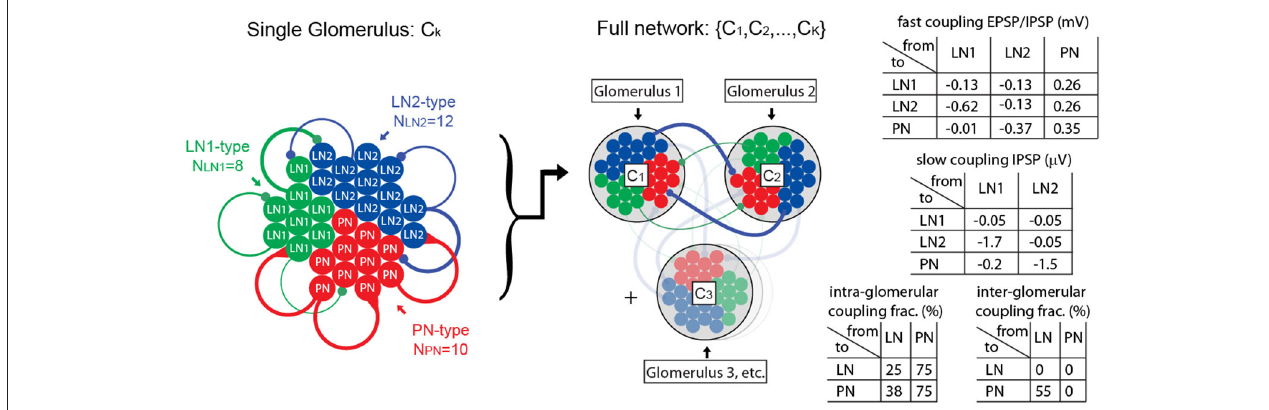
FIGURE 1 | Illustration of computational network architecture. On the left we illustrate the anatomy of a single glomerulus, comprising 10 PNs, 8 LN1s, 12 LN2s, each modeled using single-compartment integrate-and-fire equations. These neuronal populations are connected together sparsely via local intra-glomerular connections. Representative connections are illustrated in this diagram with colored lines, the thickness of which roughly corresponds to the coupling strength. In the middle we illustrate our full network, comprising K glomeruli (e.g., K = 2 –6). The neuronal populations within each of these glomeruli are connected together sparsely via long-range inter-glomerular connections; these long-range connections have the same synaptic strength as the intra-glomerular connections, but are randomly connected using different sparsity coefficients. On the right we list a few tables for the synaptic coupling strengths (given in terms of approximate EPSP and IPSP amplitudes), and sparsity coefficients. A full description of the network, as well as the parameters involved, is given in the Supplementary